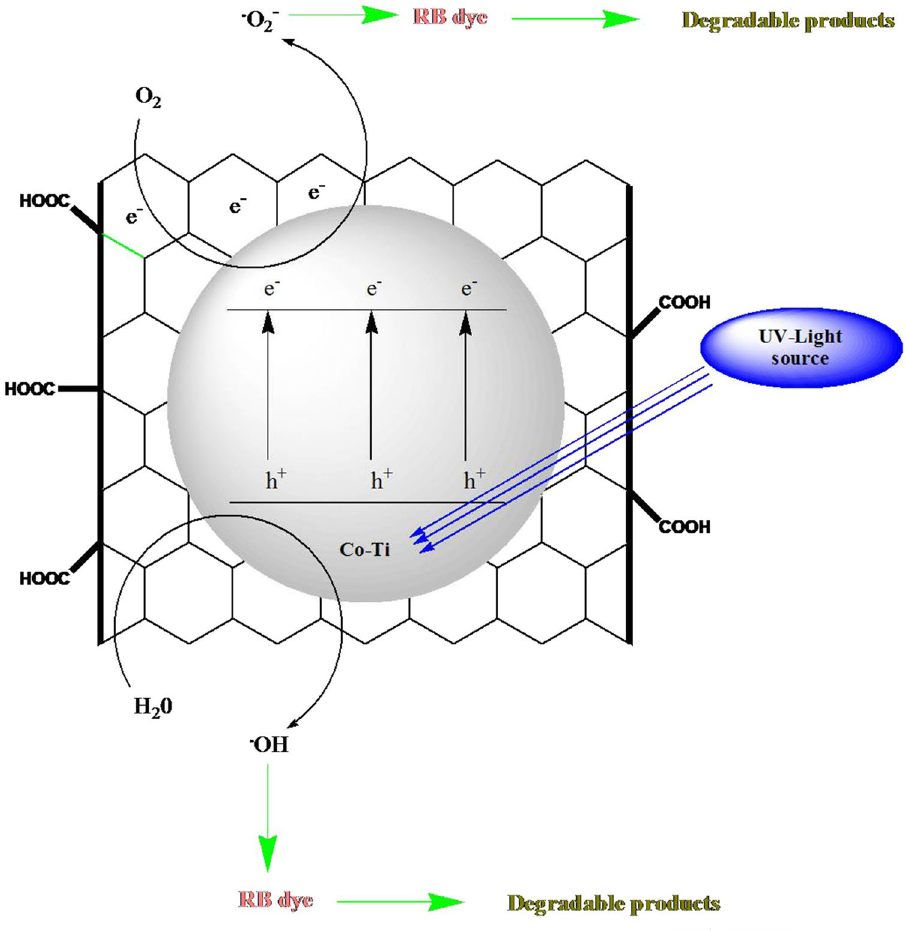
Fig. 5 General proposed mecha- nism for CR dye photodegrada-